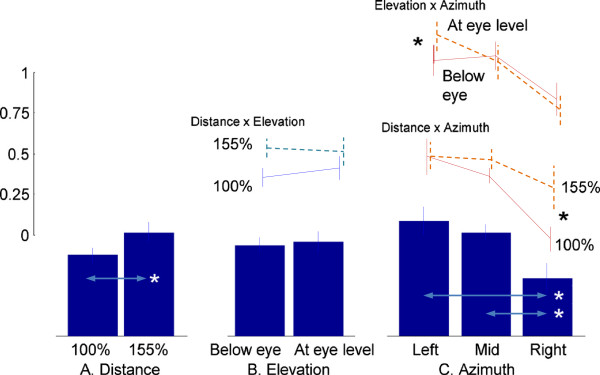
Proportion of torso movement contribution allocated to MS (torso lateral bending). Values on the y-axis are in a [0,1] scale and unitless (as defined in Equation 6). A value > 0.5 indicates that a larger torso movement contribution is allocated to MS than VS. *denotes a statistically significant difference at p < 0.05. A: Distance, B: Elevation, and C: Azimuth effects.